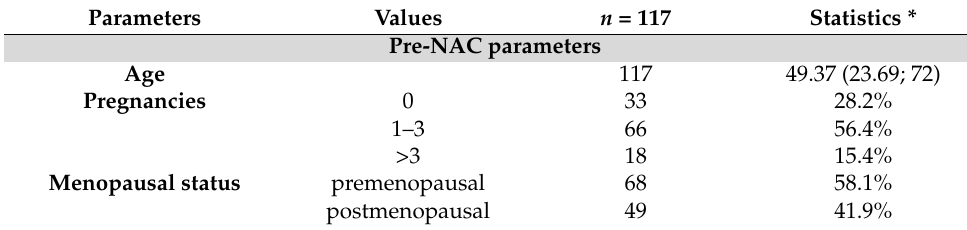
Table 1. Patients and tumor